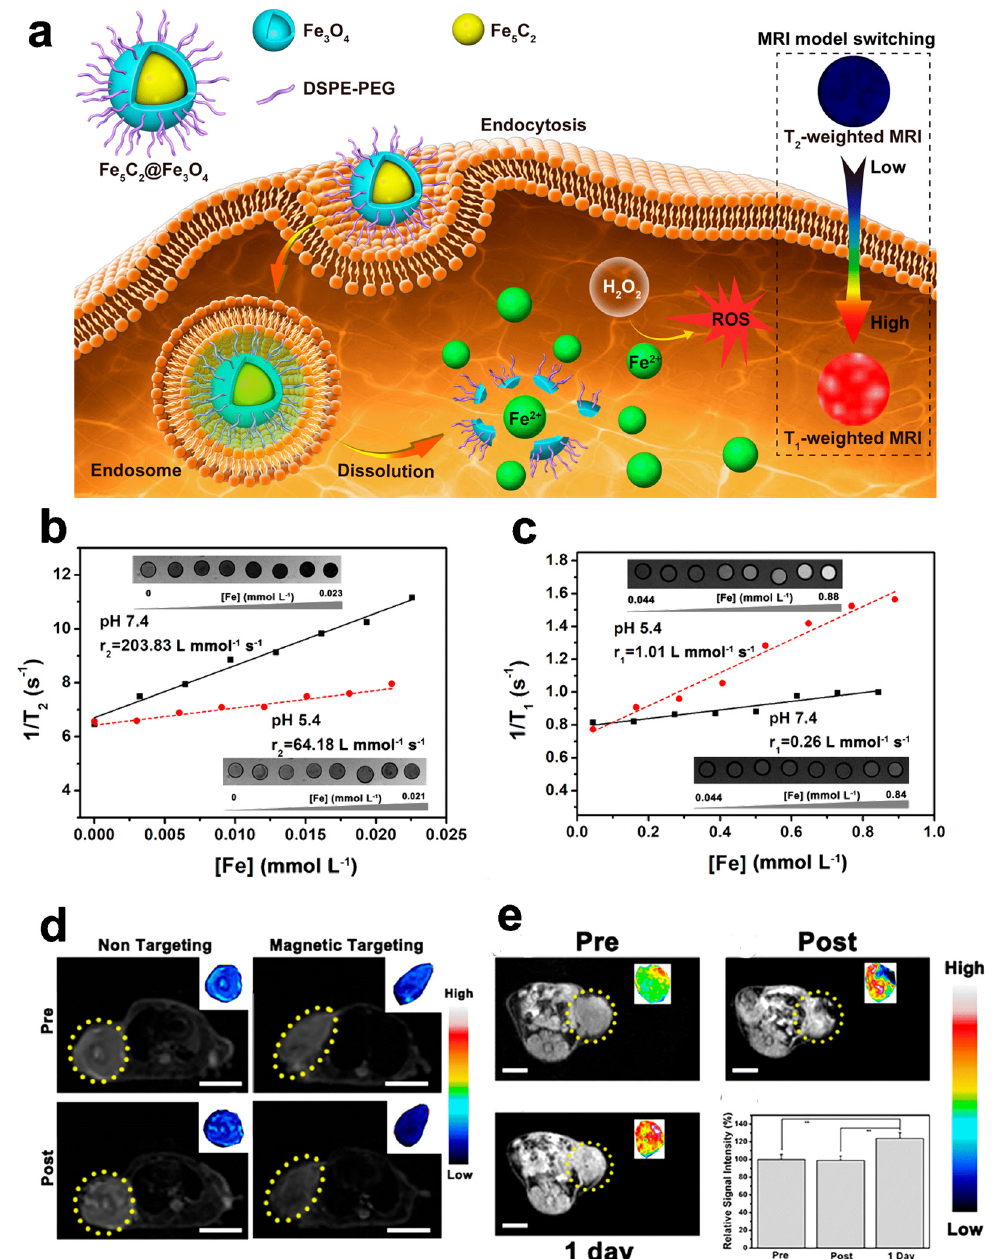
Figure 1. Fe 5 C 2 @Fe 3 O 4 NPs for MRI. ( a ) Schematic illustration of Fe 5 C 2 @Fe 3 O 4 NPs with Ph-responsive Fe 2+ release, ROS generation, and T 2 / T 1 signal-conversion abilities. ( b , c ) pH-dependent MRI mode switching of PEG/Fe 5 C 2 @Fe 3 O 4 nanoparticles. ( d ) Representative T 2 —weighted MR images. ( e ) Representative T 1 —weighted MR images. Reproduced with permission from Ref. [99]. Copyright © 2019 American Chemical Society. ** p <